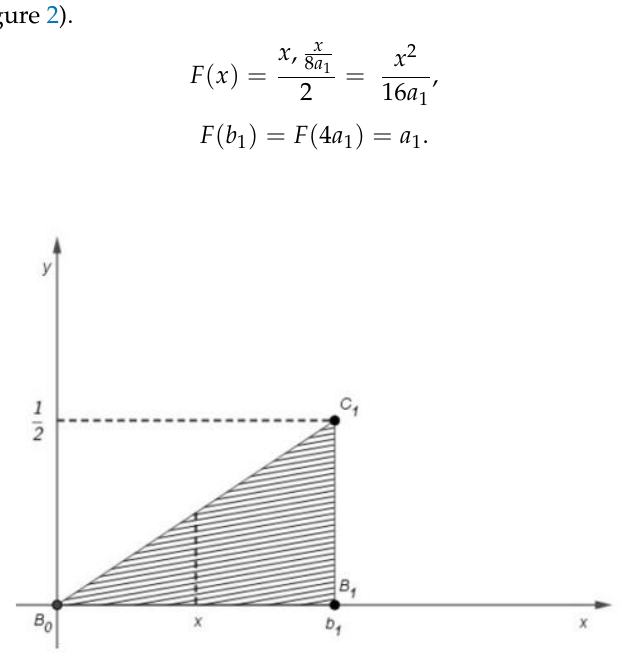
Figure 2. The area of the triangle, defined by points 𝐵 0 , 𝑋 1 , 𝑋 2 .